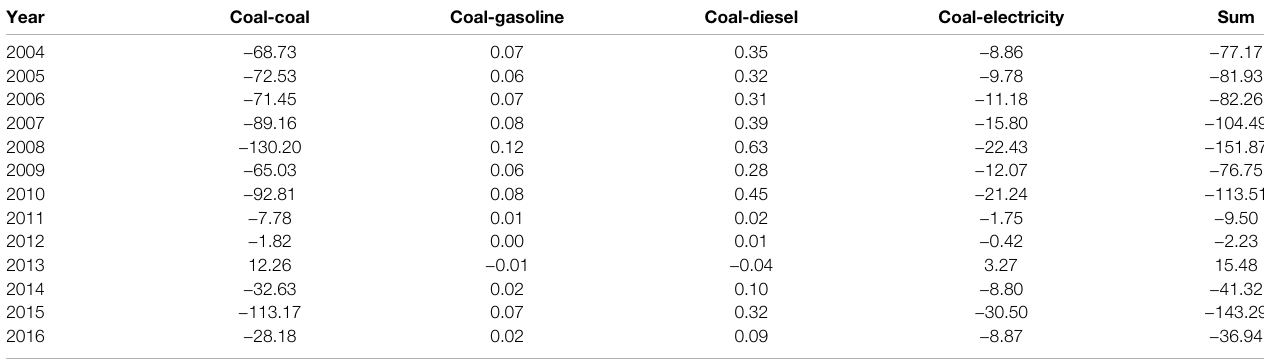
TABLE 5 | Carbon mitigation potential by removing coal price distortions (million tons of CO 2 ).